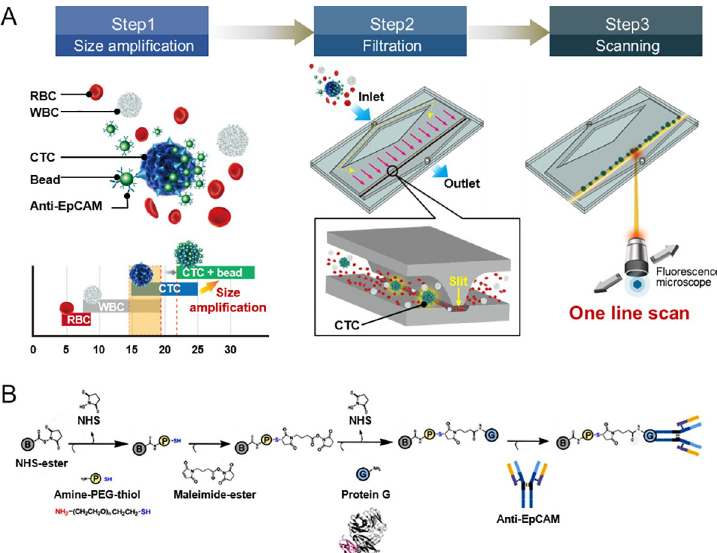
Fig 1. Schematic of the microslit filter chip to isolate circulating tumor cells. ( A ) The workflow of the microslit filter system consisting of 3 steps. Step 1 (size amplification): Cell size distribution in whole blood. WBCs and CTCs overlap. However, by conjugating the CTCs with functionalized microbeads, the WBCs and CTC-bead constructs are distinguishable. Step 2 (filtration): The CTC-bead constructs are captured by the 8 μ m deep microslit, while the other cells in the whole blood pass the slit. Step 3 (Scanning): CTCs are simply and rapidly identified with 1D scan. ( B ) Coupling chemistry of the bead functionalization, after the standard EDC/NHS coupling to a carboxyl-bead (B). Further steps in the process included a thiol-PEG-amine (P), maleimide-ester, protein G (G) and finally,